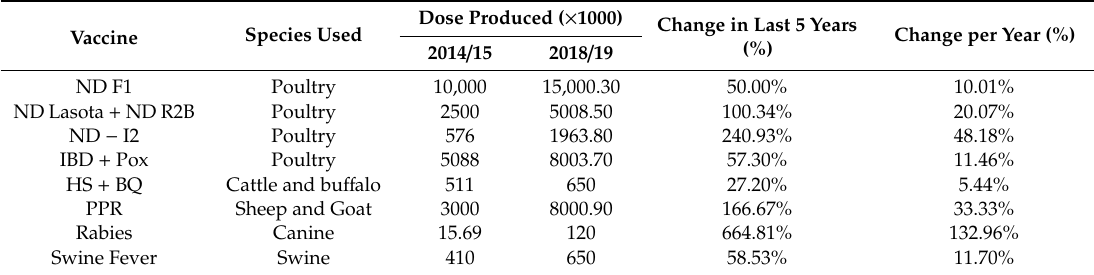
Table 5. Trend of livestock and poultry vaccine productions at the National Vaccine Production Laboratory (NVPL), Nepal [43].